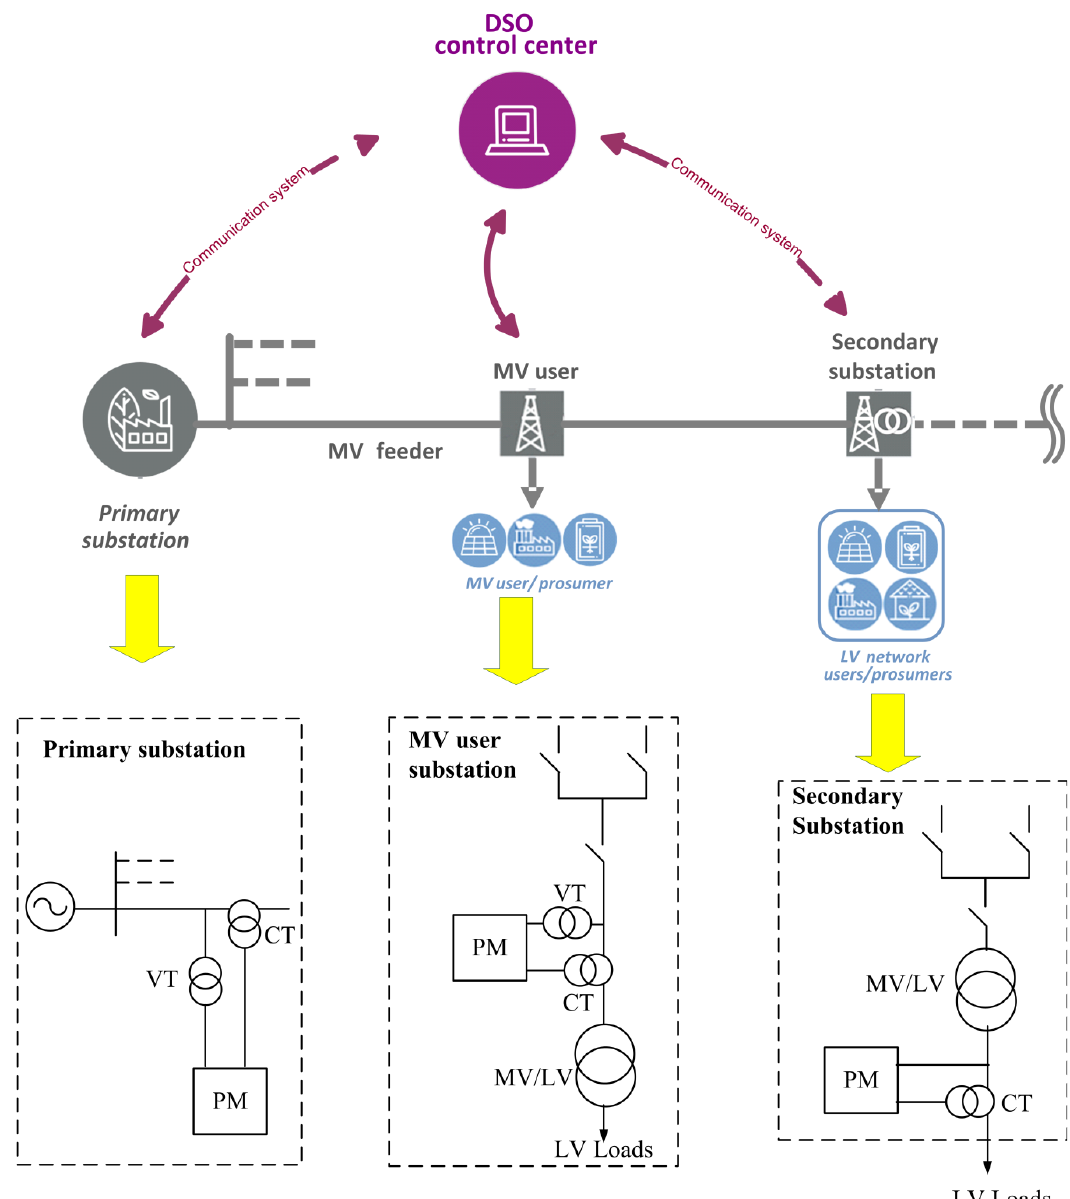
Figure 1 . Measurement system architecture for medium-voltage (MV) network monitoring based on both MV and low-voltage (LV) load power measurements.